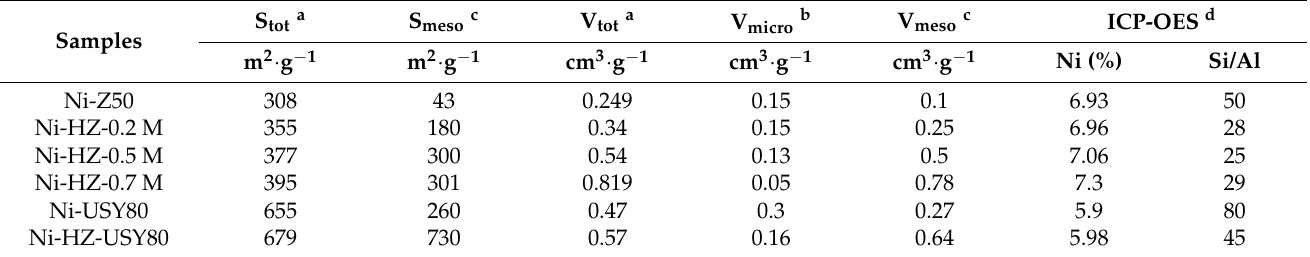
Table 1. Characterization data of Ni-supported hierarchical zeolites